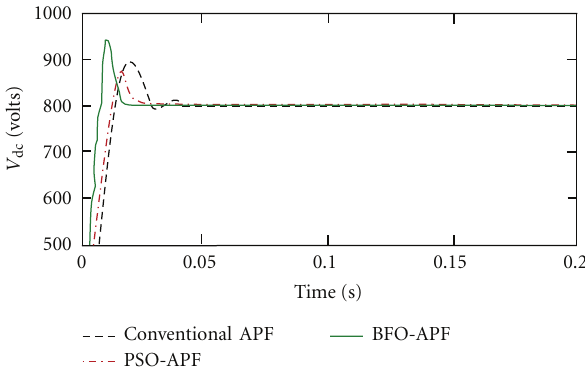
APFs with any of the PI controller tuning methods. But under unbalanced supply, BFO has better command over the dc-link voltage, and, hence, ultimately the distortion in source current is lowered down